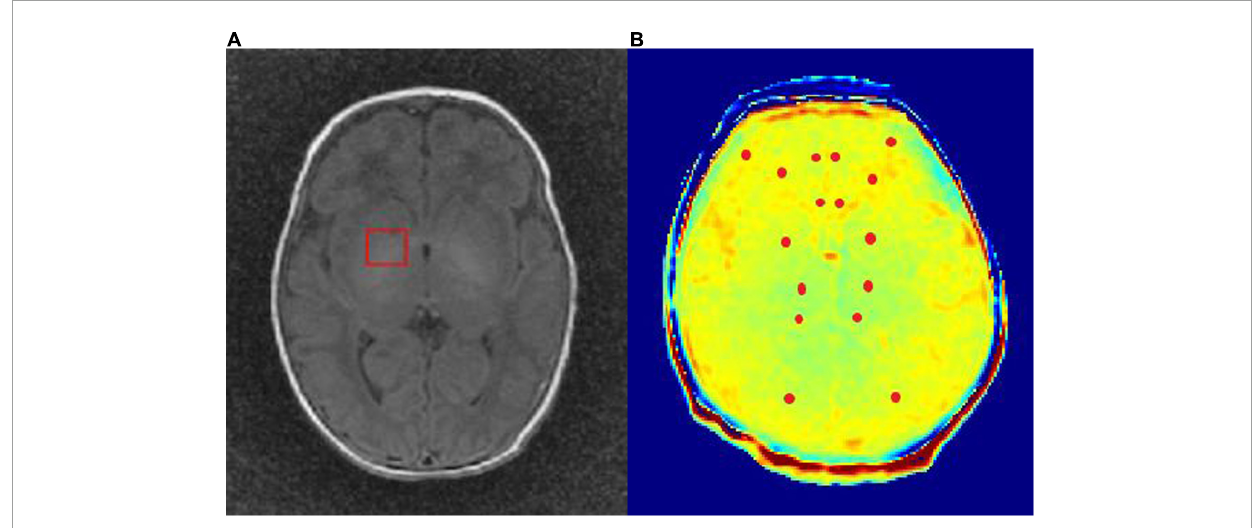
FIGURE1 (A) For 1 H-MRS acquisition, the level of the right basal ganglia was selected for the region of interest (ROI). (B) The ROI of glutamate chemical exchange saturation transfer (Glu-CEST) image post-processing included bilateral basal ganglia, thalamus, frontal cortex, frontal white matter, genu of the corpus callosum, cingulate gyrus, occipital white matter, and medial geniculate body.